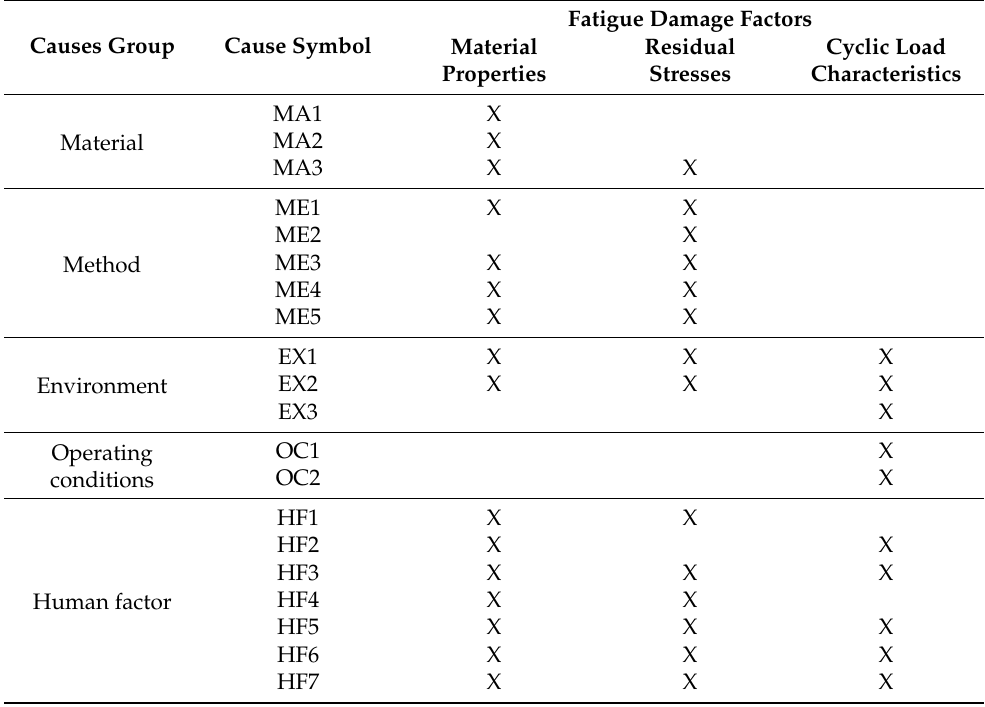
Table 10. List of the factors affecting cracks of manholes. Causes Group Cause Symbol